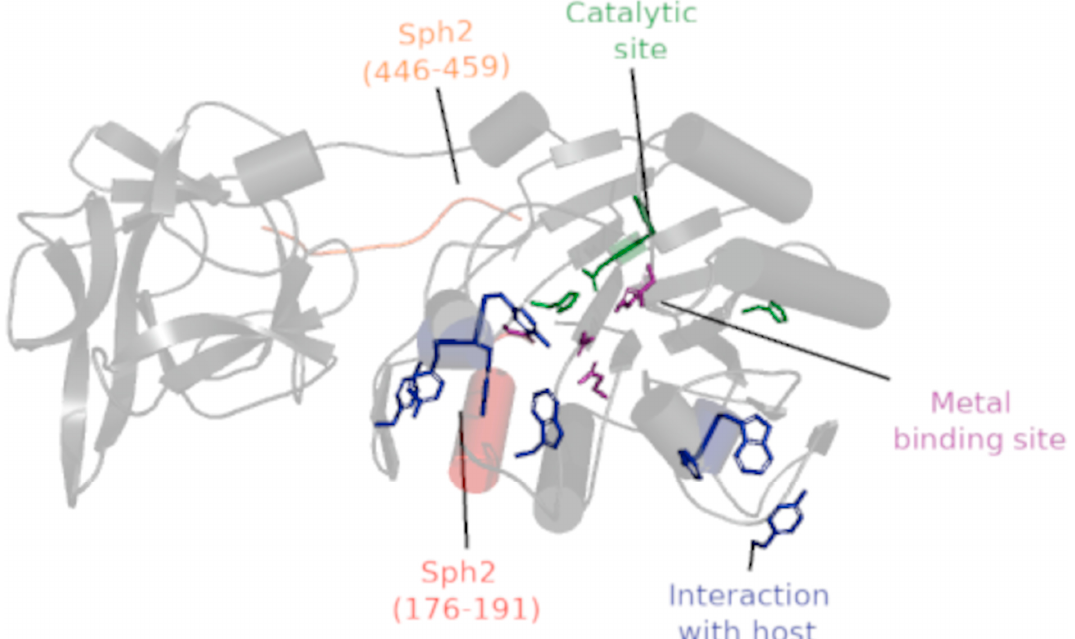
Figure 1. L. interrogans serovar Lai Sph2 3D-structure (AF-P59116-F1). The protein chain is indicated by a gray cartoon, where the catalytic site, metal-binding site, and amino acids associated with the interaction with the host are represented as licorice in green, purple, and blue, respectively. The locations of epitopes Sph2 (176-191) and Sph2 (446-459) are highlighted in red and orange, respectively. In the cartoon, cylindrical helices, round helices, flat sheets, and smooth loops are applied to allow better visualization of Alpha-Fold predicted protein AF-P59116-F1 (155-612) .